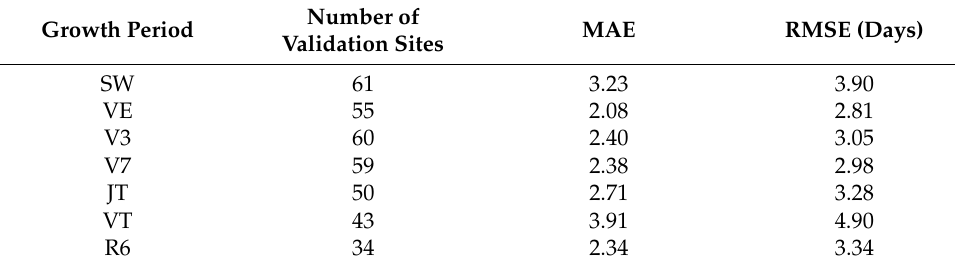
Table 3. Comparison of measured values and interpolated values at validation sites.